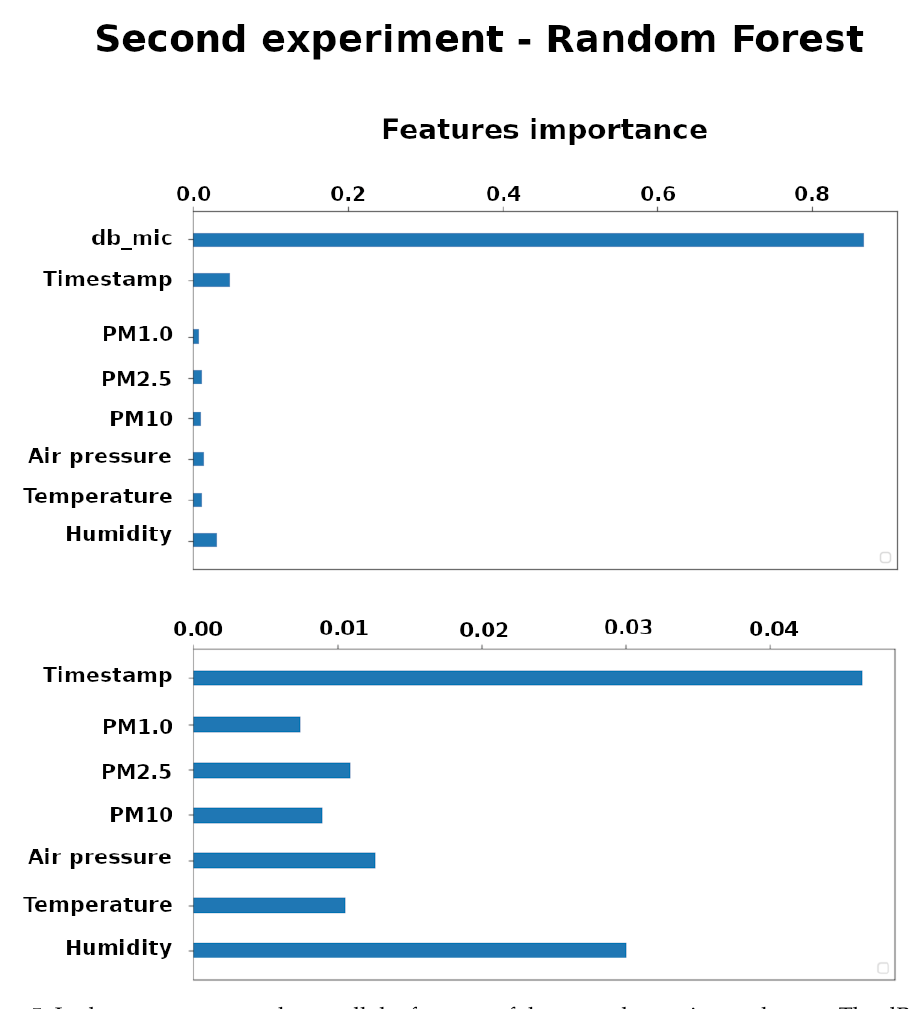
Figure 5. In the upper part are shown all the features of the second experiment dataset. The dB_mic feature has a greater importance. The dB_mic feature is omitted in the lower part to make the other features more